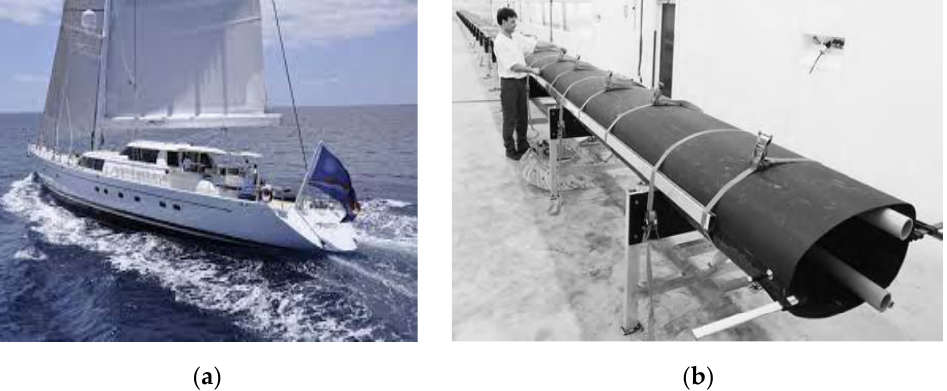
Figure 15. ( a ) Hyperion 2 yacht and ( b ) Hyperion 2 yacht mast with 59 m length fabricated from CFRP (adapted with permission from Refs. [36,55]).